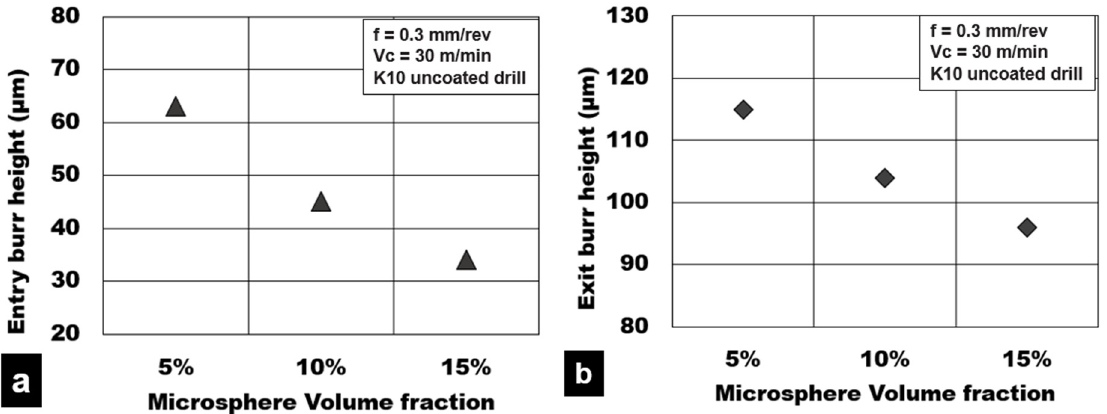
Figure 14. Effect of alumina volume fraction on burr height during machining Mg-9Al-1.4Zn-based hollow alumina syntactic foams under dry conditions: ( a ) Entry burr height and ( b ) exit burr height.